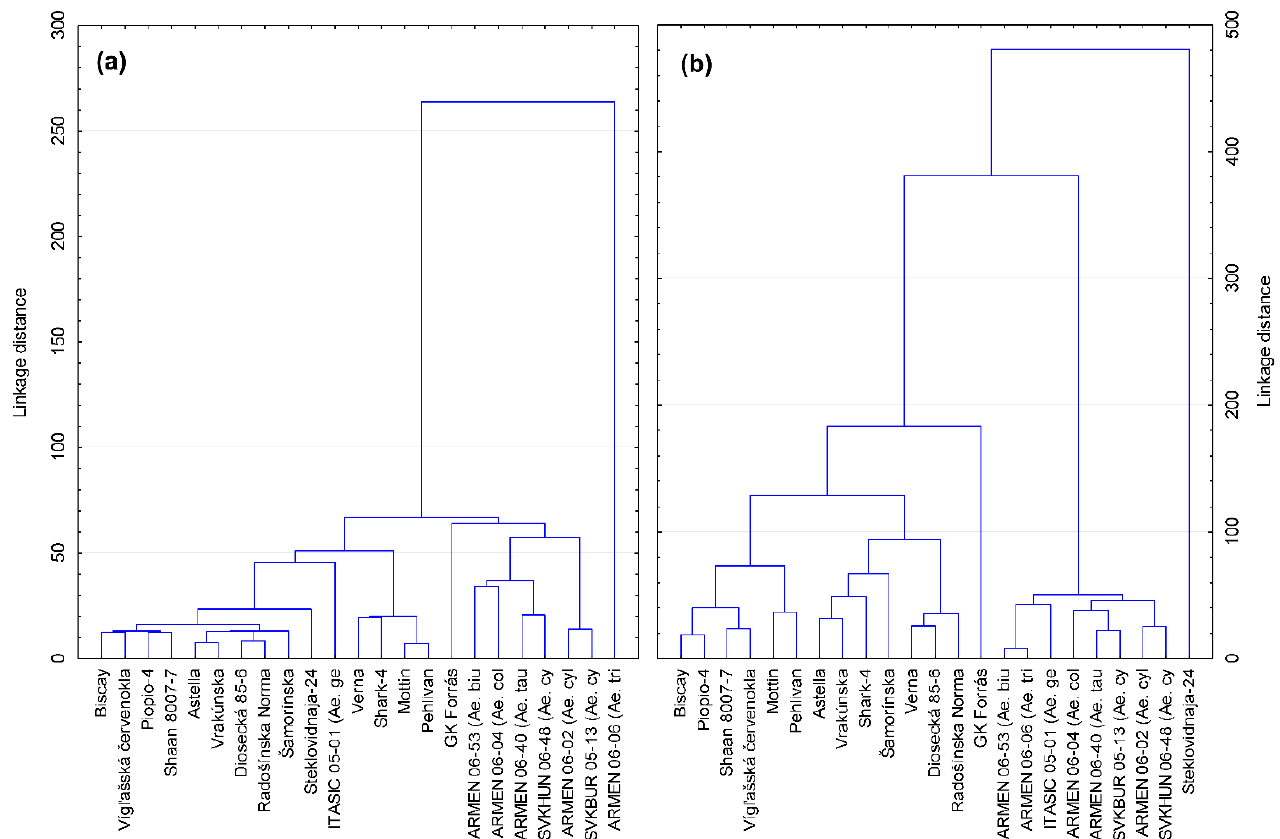
Figure 1. Dendrogram of Triticum and Aegilops genotypes obtained after applying hierarchical cluster analysis to the parameters related to cuticular transpiration ( a ) or leaf and growth parameters ( b ) using Euclidean coefficient and Ward’s method.